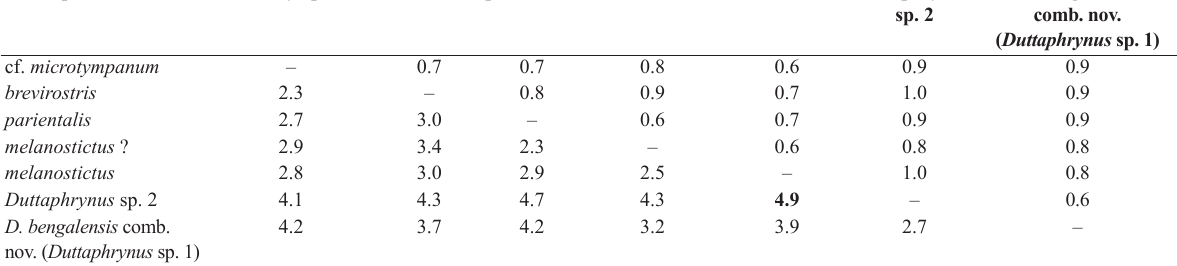
Table 1. Uncorrected genetic distances (%) between investigated 16S clades of the Duttaphrynus melanostictus complex as shown in the Fig. 1A. Given are p-distance values (lower-left) and standard error estimates (upper-right). Clade p -distances (%) cf. microtympanum brevirostris parientalis melanostictus ? melanostictus Duttaphrynus